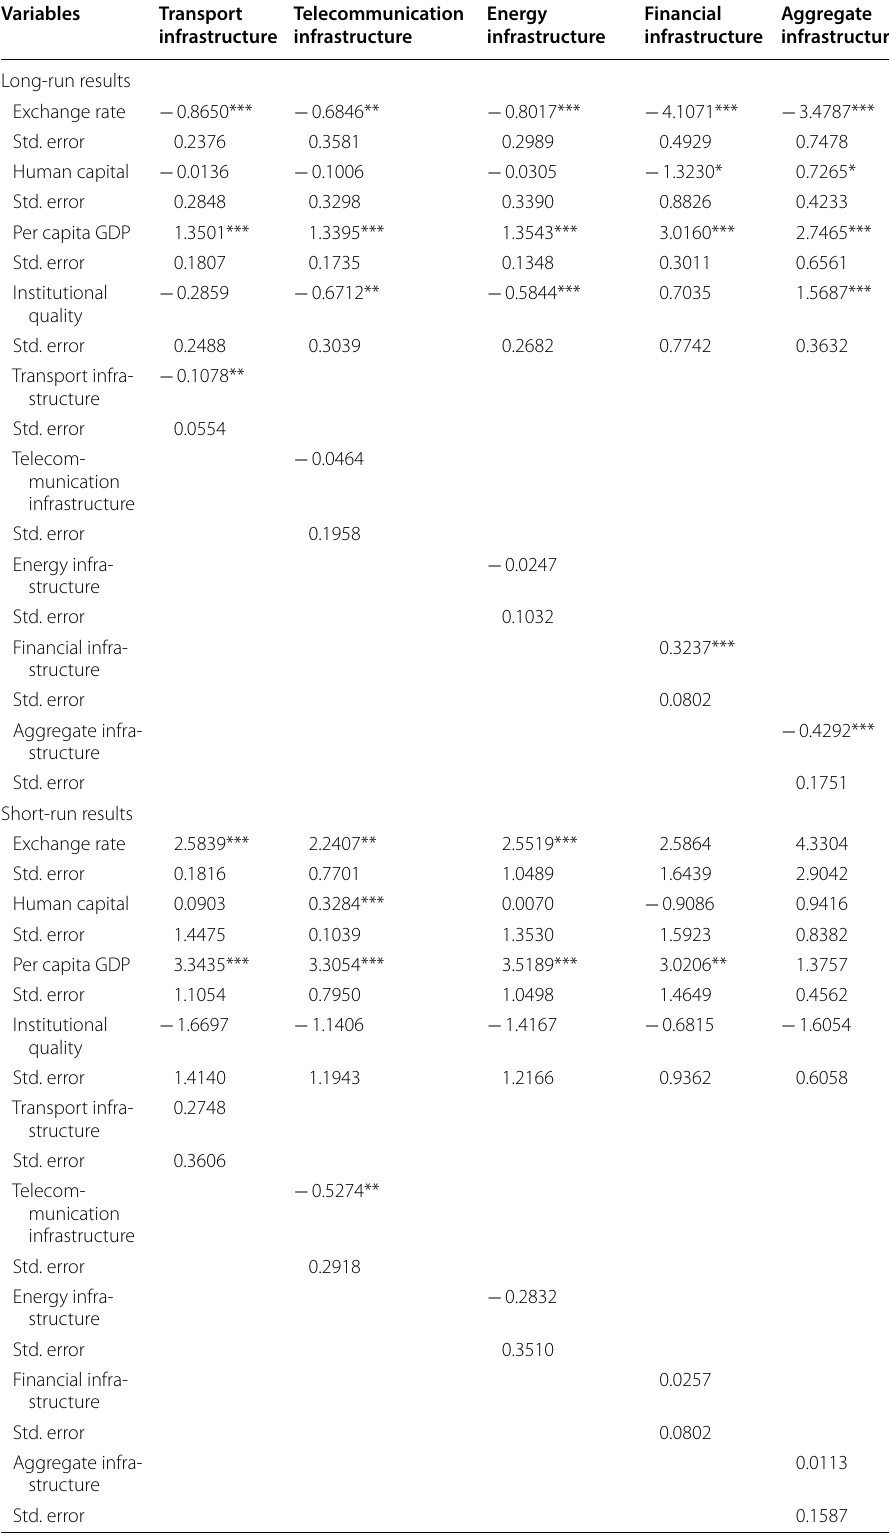
Table 4 Pooled Mean Group estimator results (trade deficit is dependent variable)